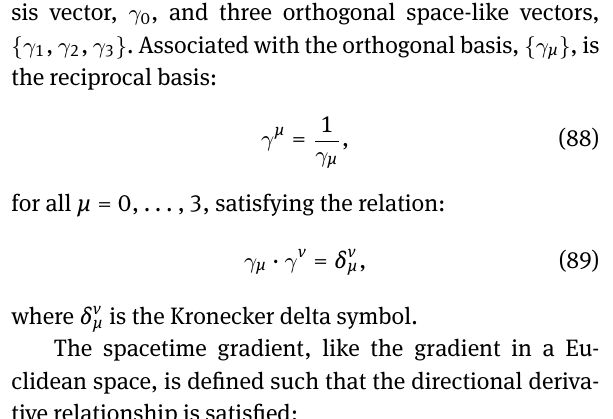
Figure 22: The coboundary process on a discrete 0-form defined for the nodes t = t 1 of a